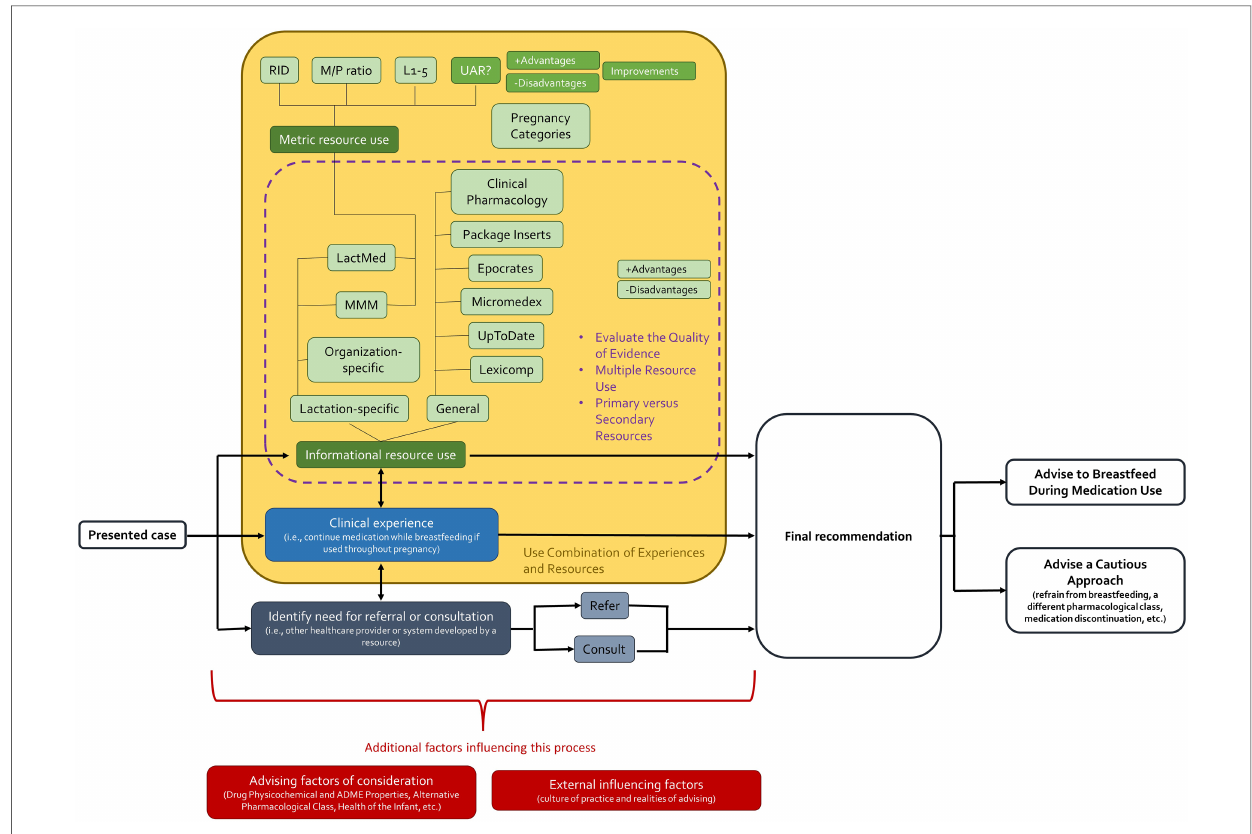
FIGURE 1 A fl ow diagram of summarized healthcare provider current practice approaches when advising mothers taking medication during breastfeeding. RID, relative infant dose; M/P ratio, milk-to-plasma ratio; L1-5, Hale ’ s Lactation Risk Categories, 1 – 5; UAR, upper area under the curve ratio; MMM, Medications and Mothers ’ Milk; ADME, absorption, distribution, metabolism, and